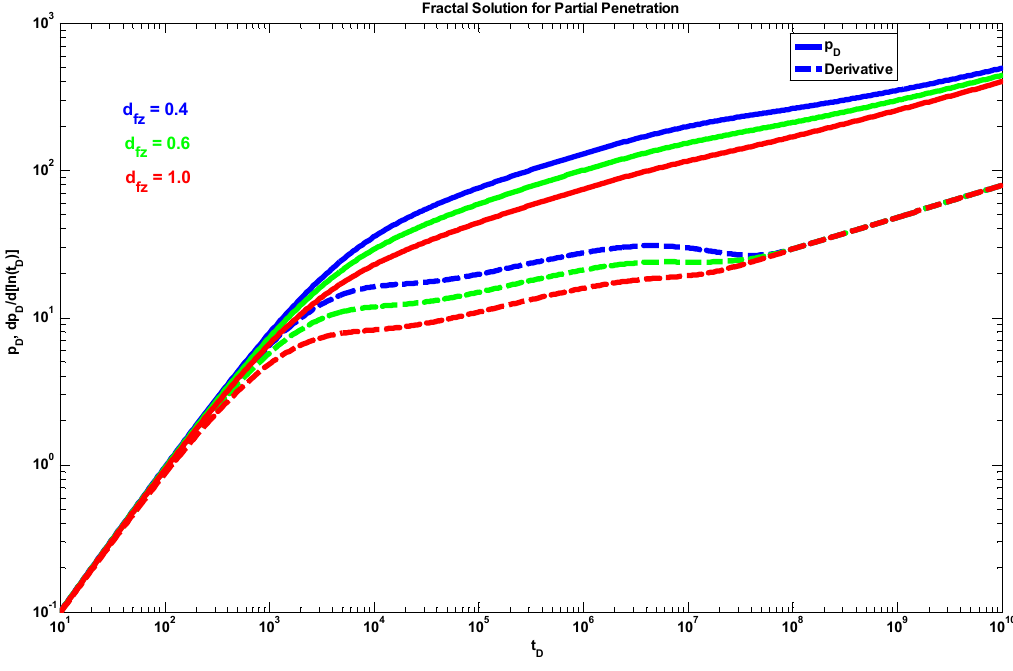
Figure 12. Fractal case: z wD = 0.2, h pD = 0.6, h D = 10,000, S = 0, C D = 100, ε = 1, d fr = 1.8, θ r = 0.3, θ z = 0.1.